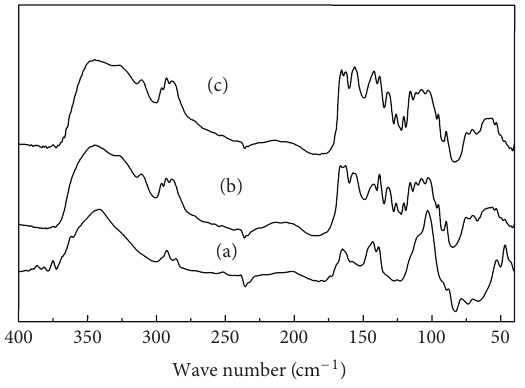
F 1: FTIR spectra of the CDNMA (a), untreated cellulose (b), and cellulosic �bers graed CDNMA